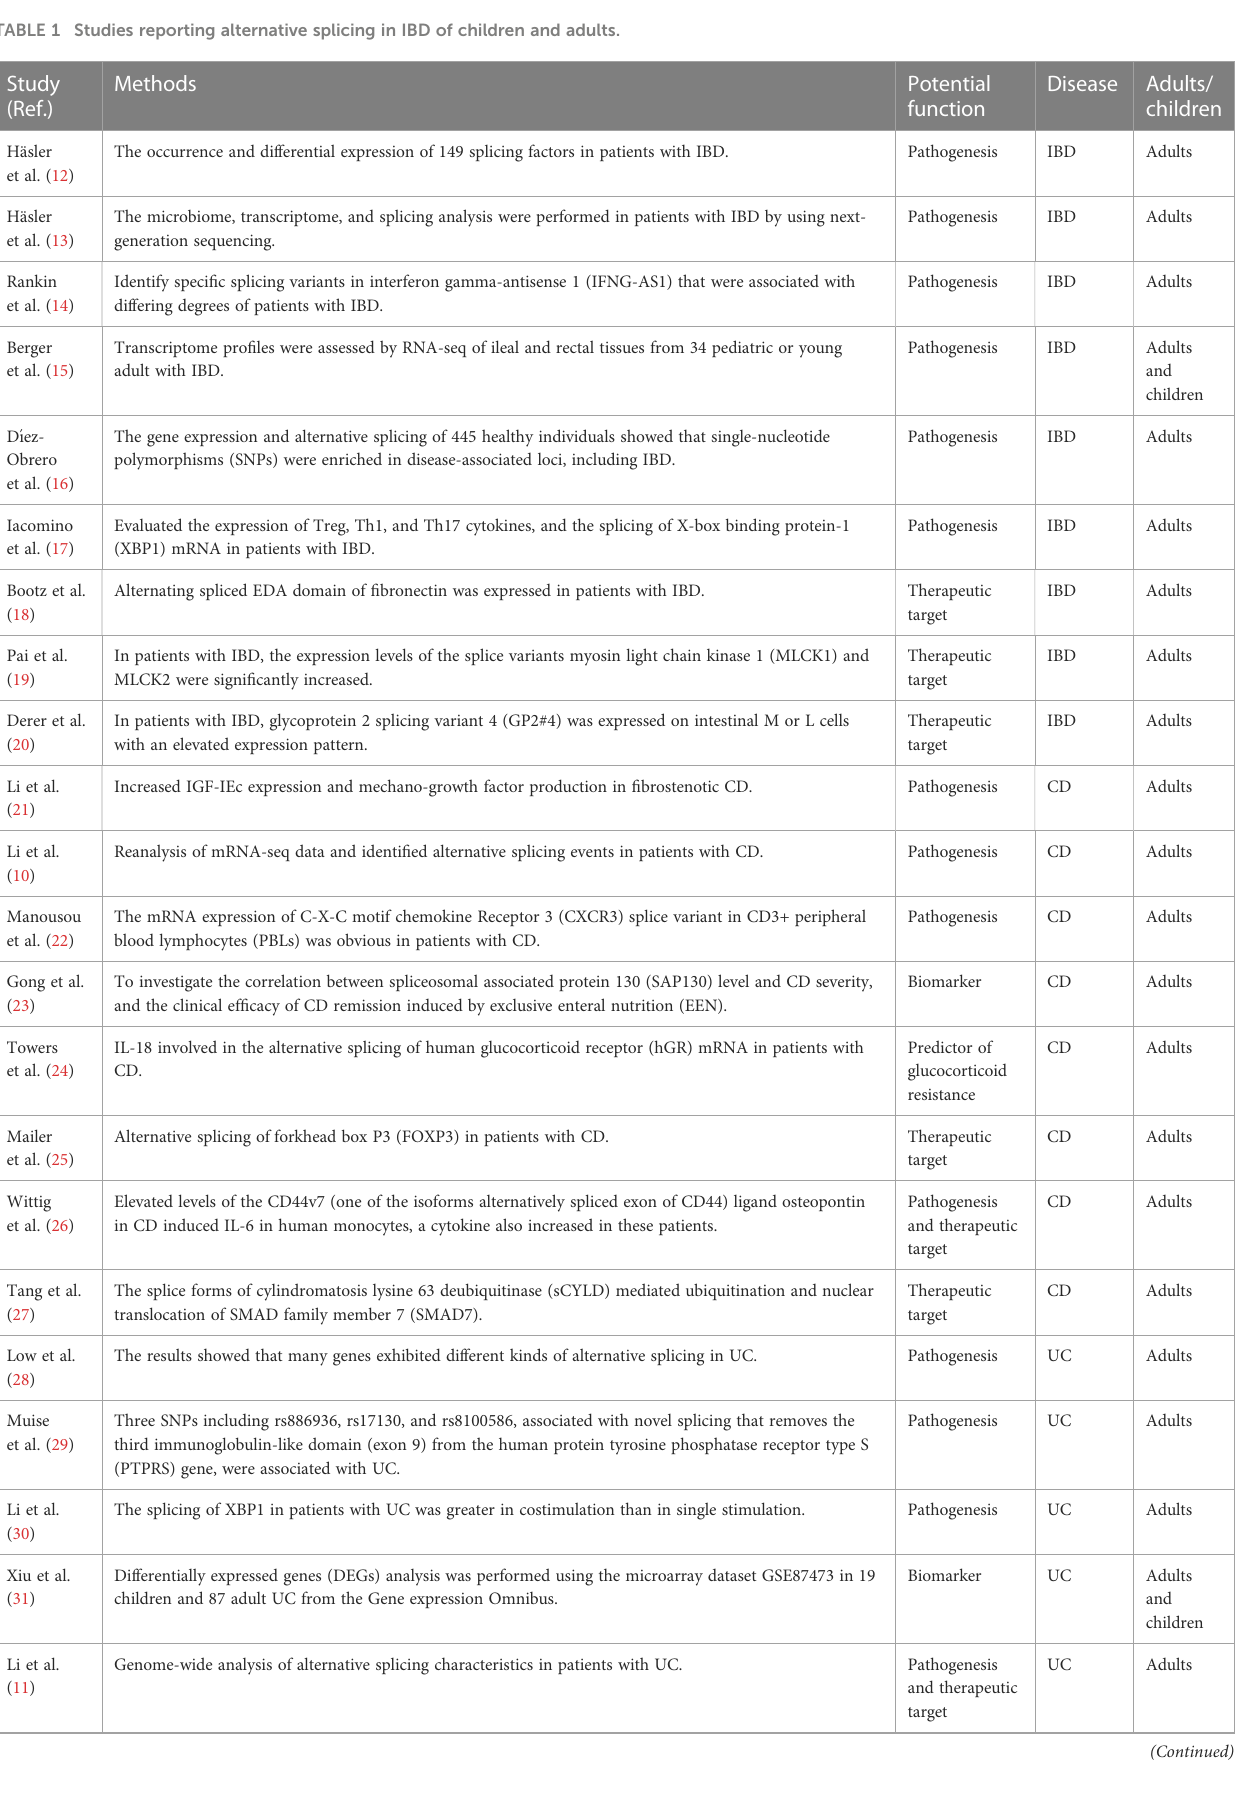
TABLE 1 Studies reporting alternative splicing in IBD of children and adults. Study